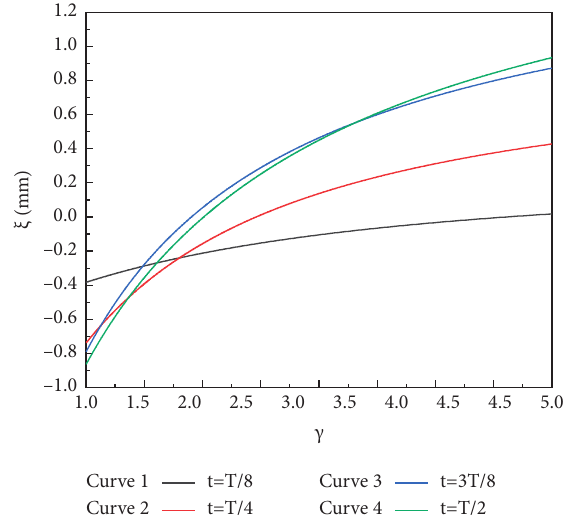
Figure 10: The relationship curve diagram of spring damping coefficient c and ξ .